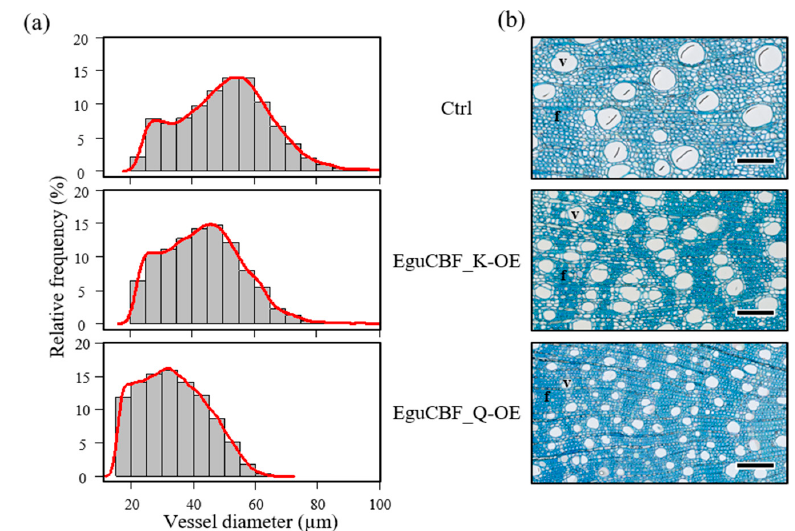
Figure 4. Vessel distribution. ( a ) Vessel diameter distribution in the secondary xylem of 6-month-old control, EguCBF_K -OE, and EguCBF_Q -OE Eucalyptus plants. ( b ) Toluidine blue O stained cross sections of secondary xylem of 6-month-old plants. The results are mean diameters ± SD of a total of 2700 to 6600 vessels measured across 3 biological replicates per line. Scale bar = 50 µ m. V: vessels; f: